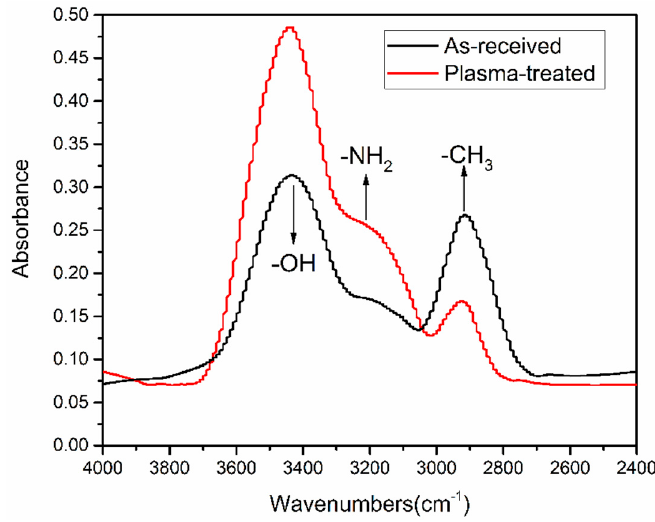
Figure 11. FTIR spectra of the as-received and plasma-treated (P 5-18 ) CFRP substrates.